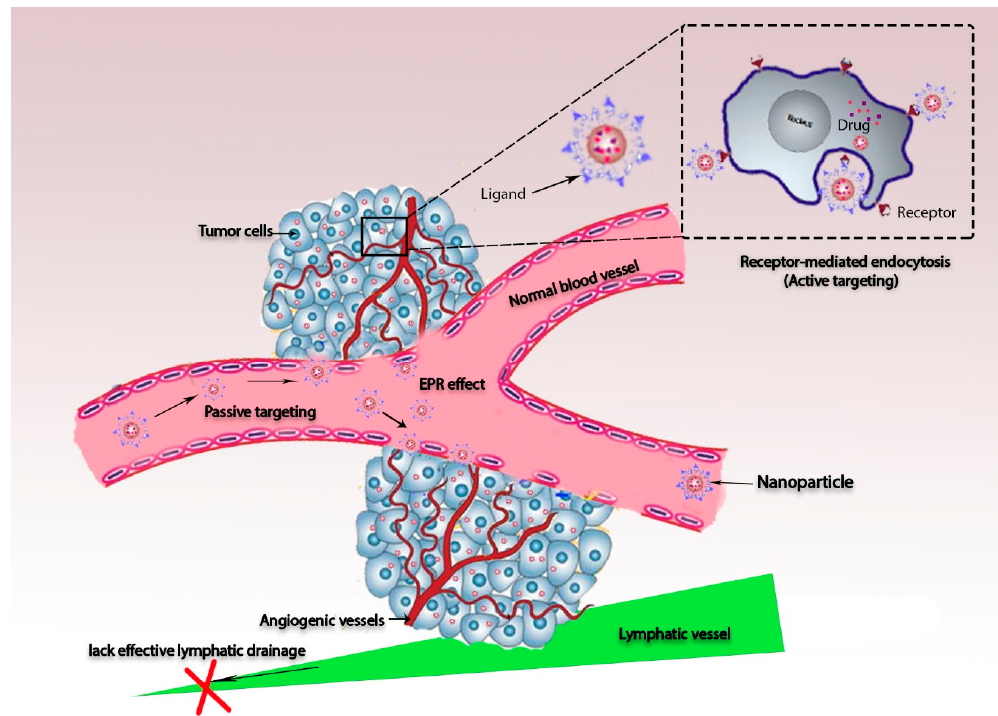
Figure 2. Schematic diagram of passive and active targeting strategies, showing accumulation of nanoparticles conjugated by ligands inside tumor tissue. The inset illustrates that the nanoparticle–ligand structure is recognized by receptors that are overexpressed on the cell membranes of cancer cells.